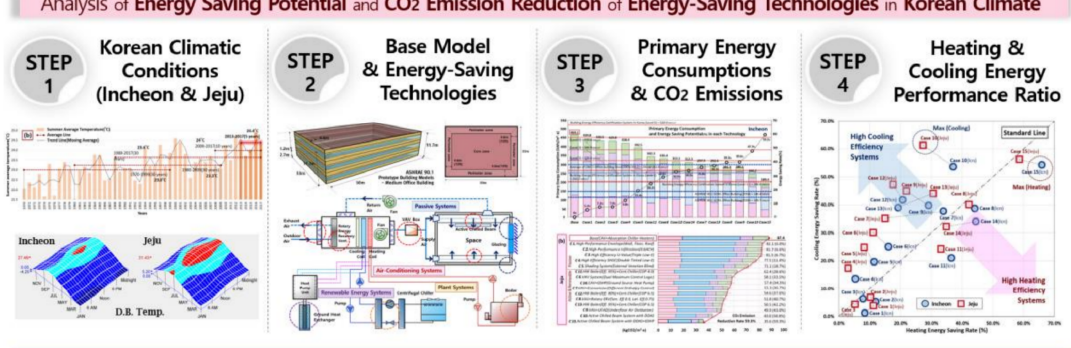
Figure 1. Flow diagram of this